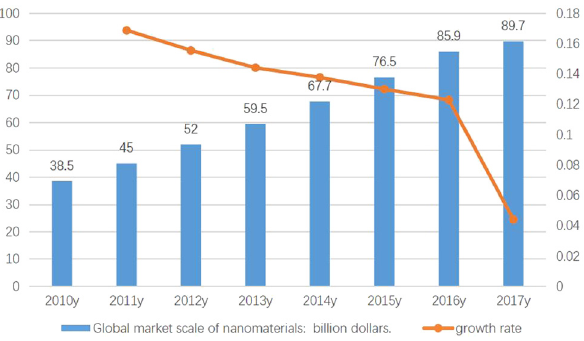
Figure 18: Global market scale of nanomaterials in 2010 – 2017 [ 165 ] .